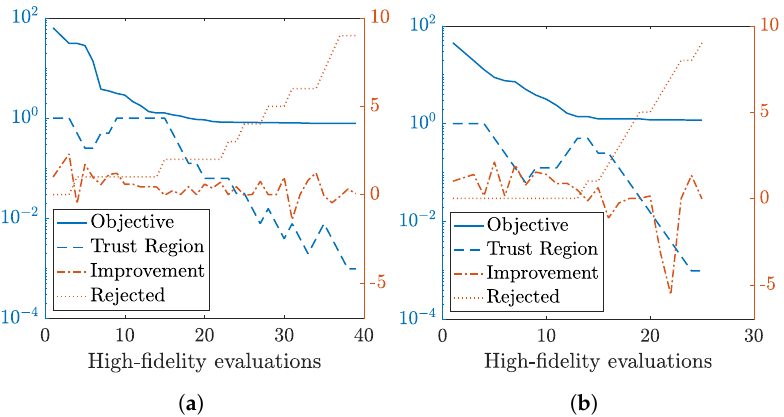
Figure 18. Performance of multi-fidelity model within simultaneous shape and structural design. ( a ) 7 DoF Kulfan; ( b ) 17 DoF